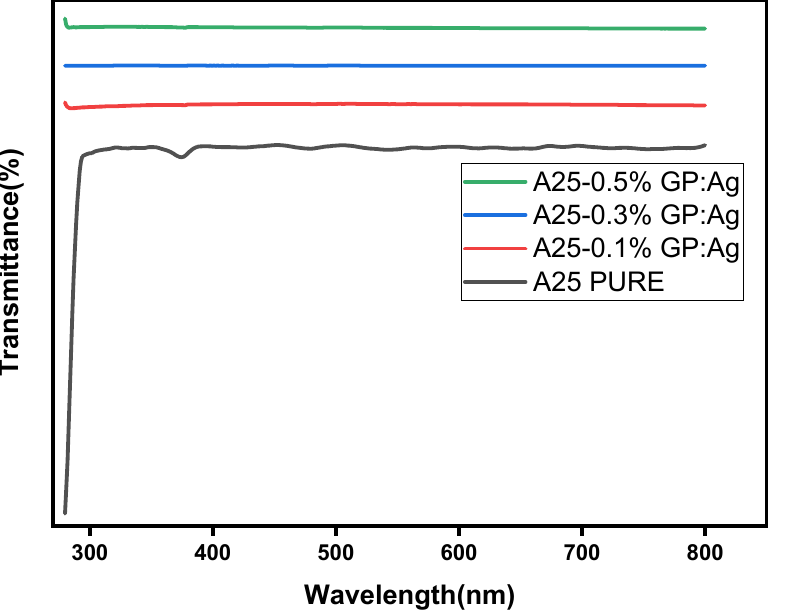
Figure 5. Light transmittance spectrum of samples. Table 2. Solar transmission of nanocomposites in different spectrums.